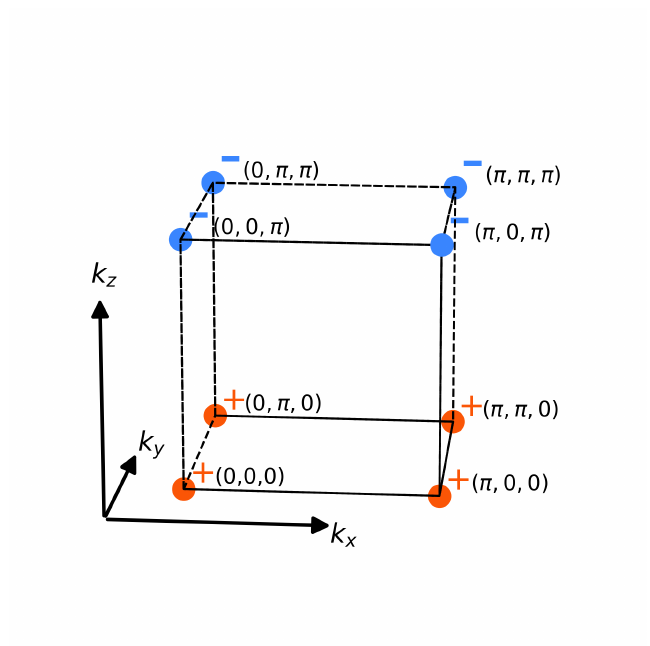
Figure 4: Product of inversion eigenvalue of the occupied band manifold at TRIM points in reduced coordinates. Non trivial inversion winding can be seen along k direction with inversion eigenvalues being exchanged.